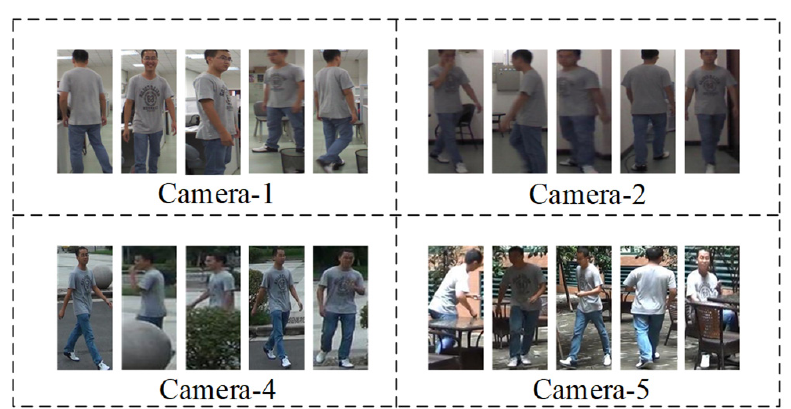
Figure 1. Images taken by different color cameras of one pedestrian.